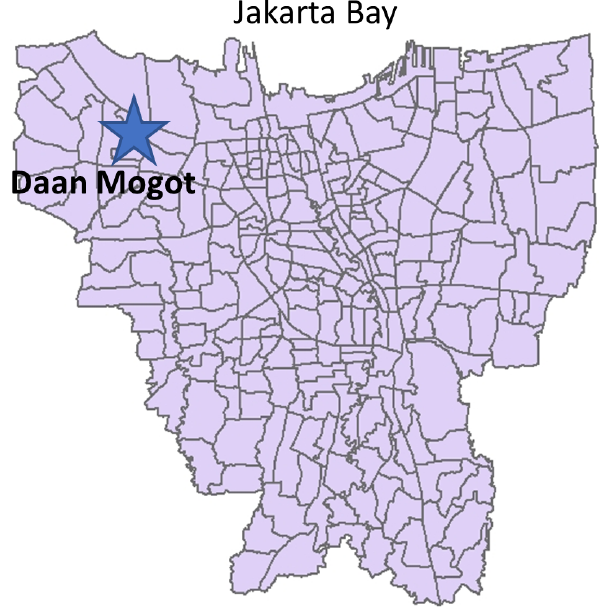
Figure 2. Location of study site within greater Jakarta. Map is ap- proximately 40 × 40km.